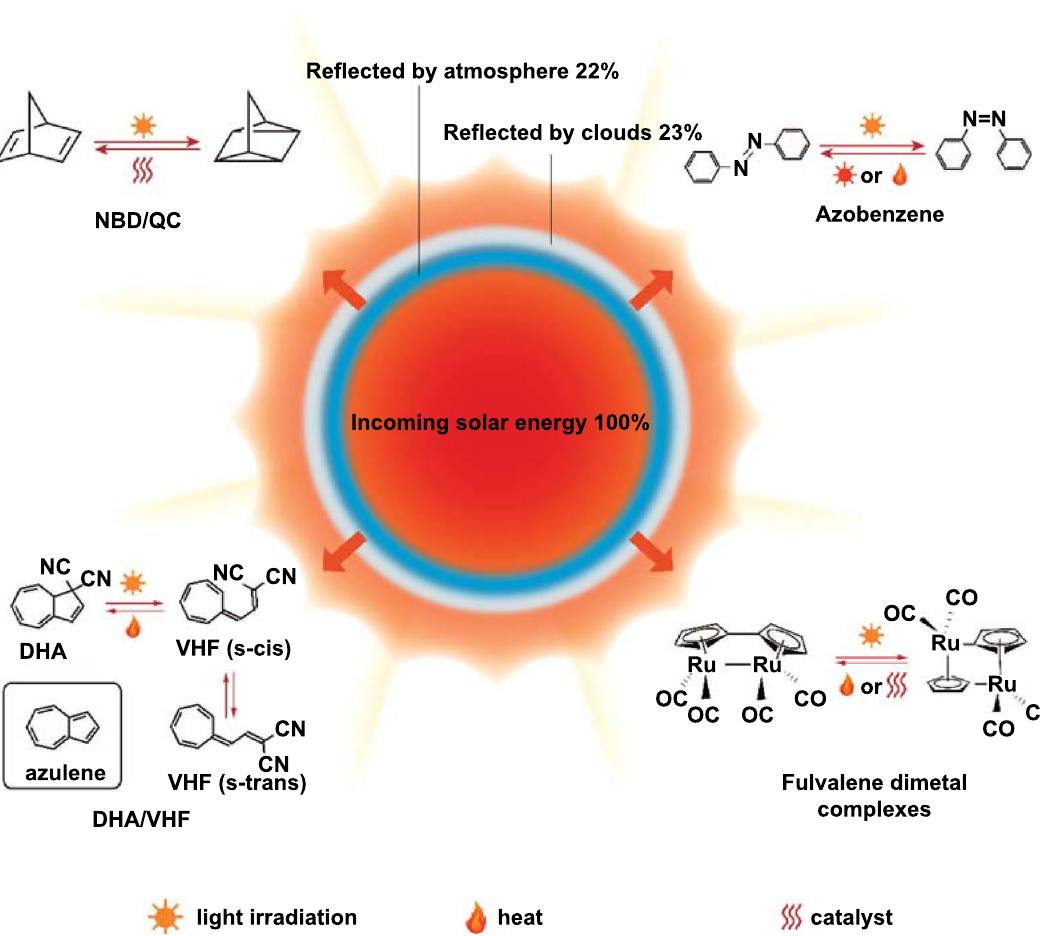
Fig. 1 Photoisomerization of four different types of molecular photoswitches